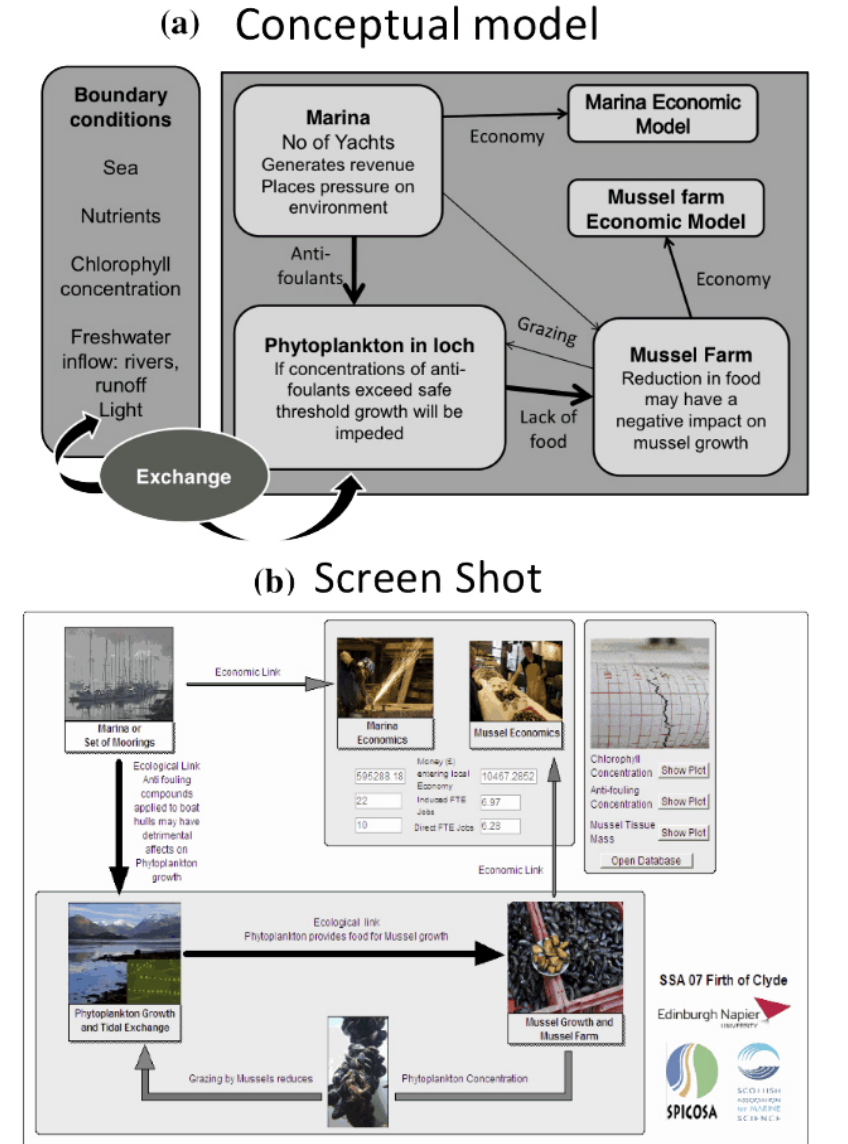
Fig. 3 . The system model: (a) conceptual model, (b) the ‘front page’ of the ExtendSim